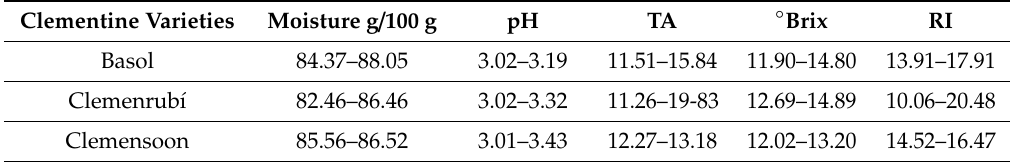
Table 1. Physicochemical characteristics (range of variation) of extra early clementine varieties. Clementine